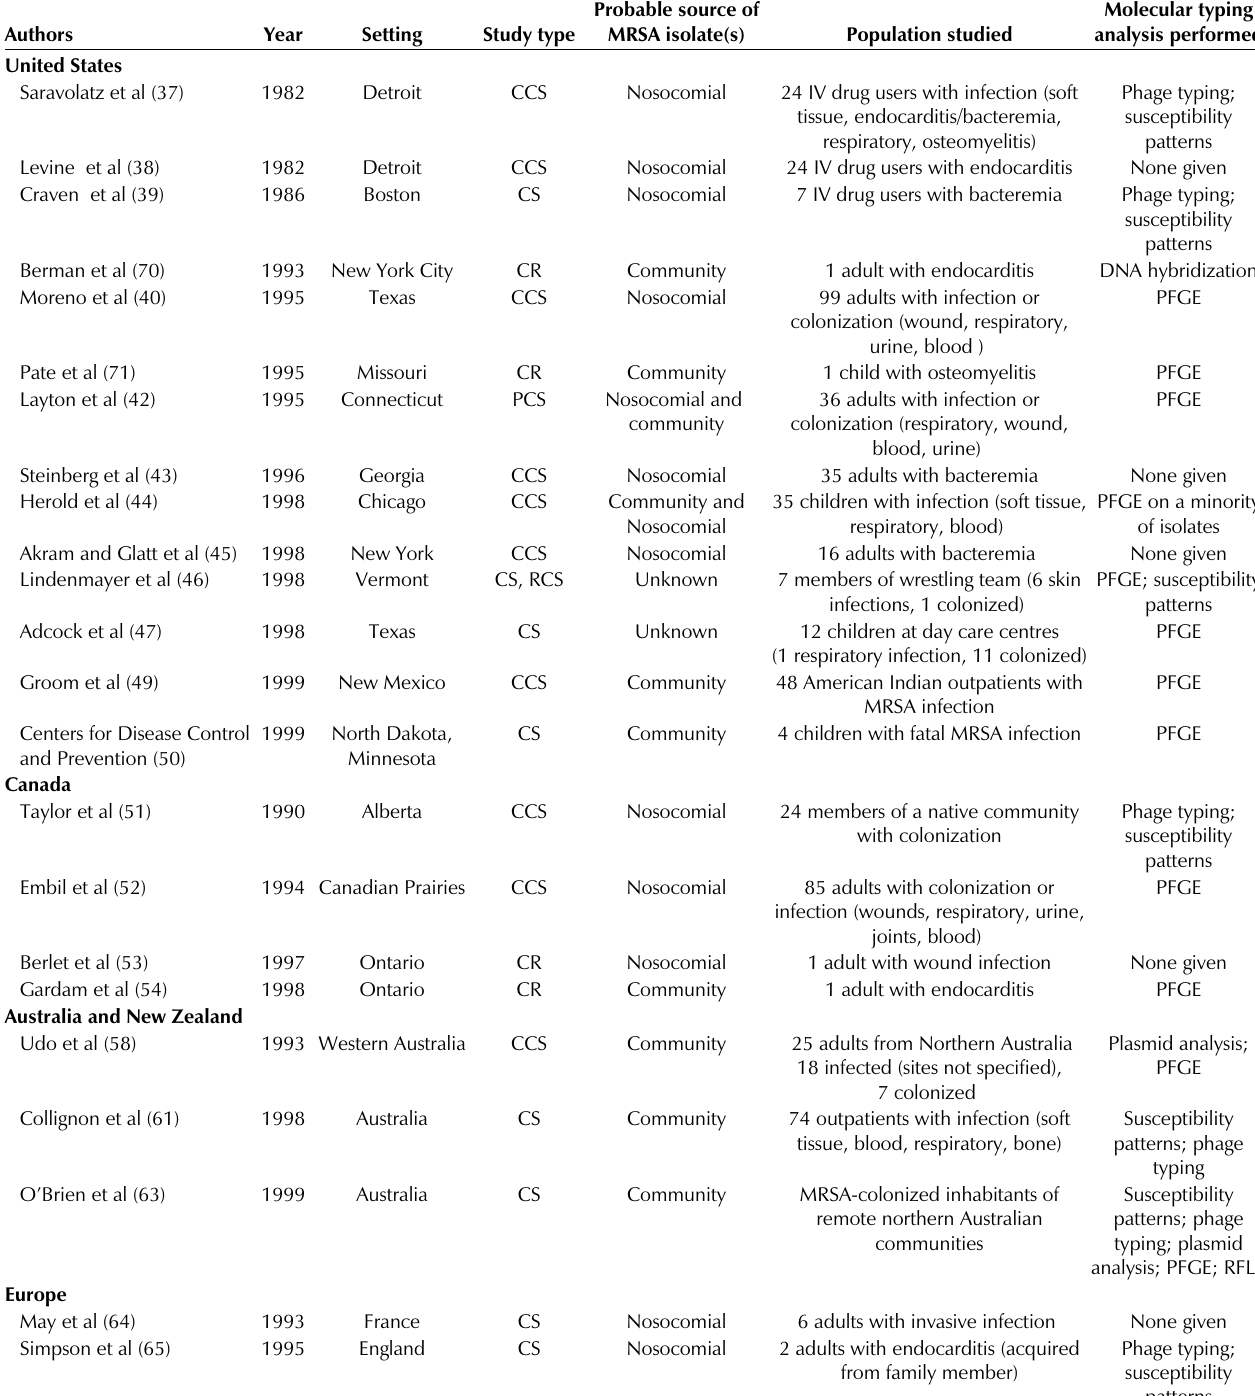
TABLE 1 Summary of the community-acquired methicillin-resistant Staphylococcus aureus (MRSA) reported in the literature Authors Year Setting Study type